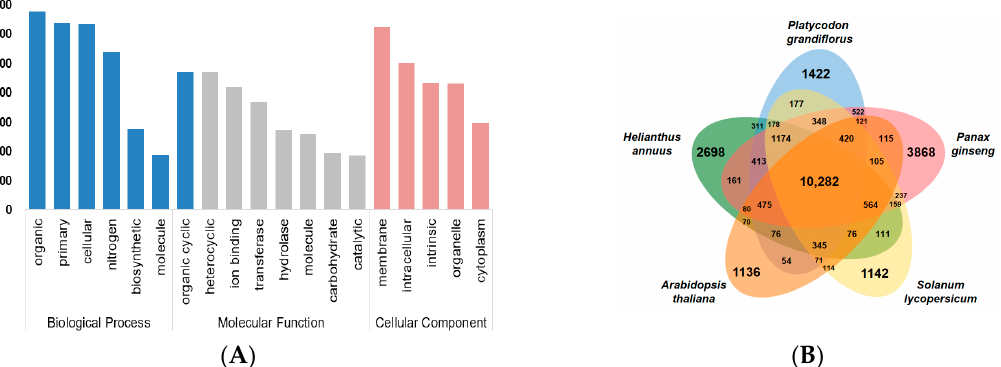
Figure 2. Gene distribution of P. grandiflorum . ( A ) Gene ontology (GO) classification of genes. The 17,286 genes assigned to GO terms were classified in functional categories based on GO terms at level 3. The Y -axis is the number of genes. ( B ) Shared and unique gene clusters in P. grandiflorum and four related species. Venn diagram illustrating the number of shared and unique gene clusters among P. grandiflorum (Korean bellflower), P. ginseng (Korean ginseng), H. annuus (sunflower), S. lycopersicum (tomato), and Arabidopsis thaliana .